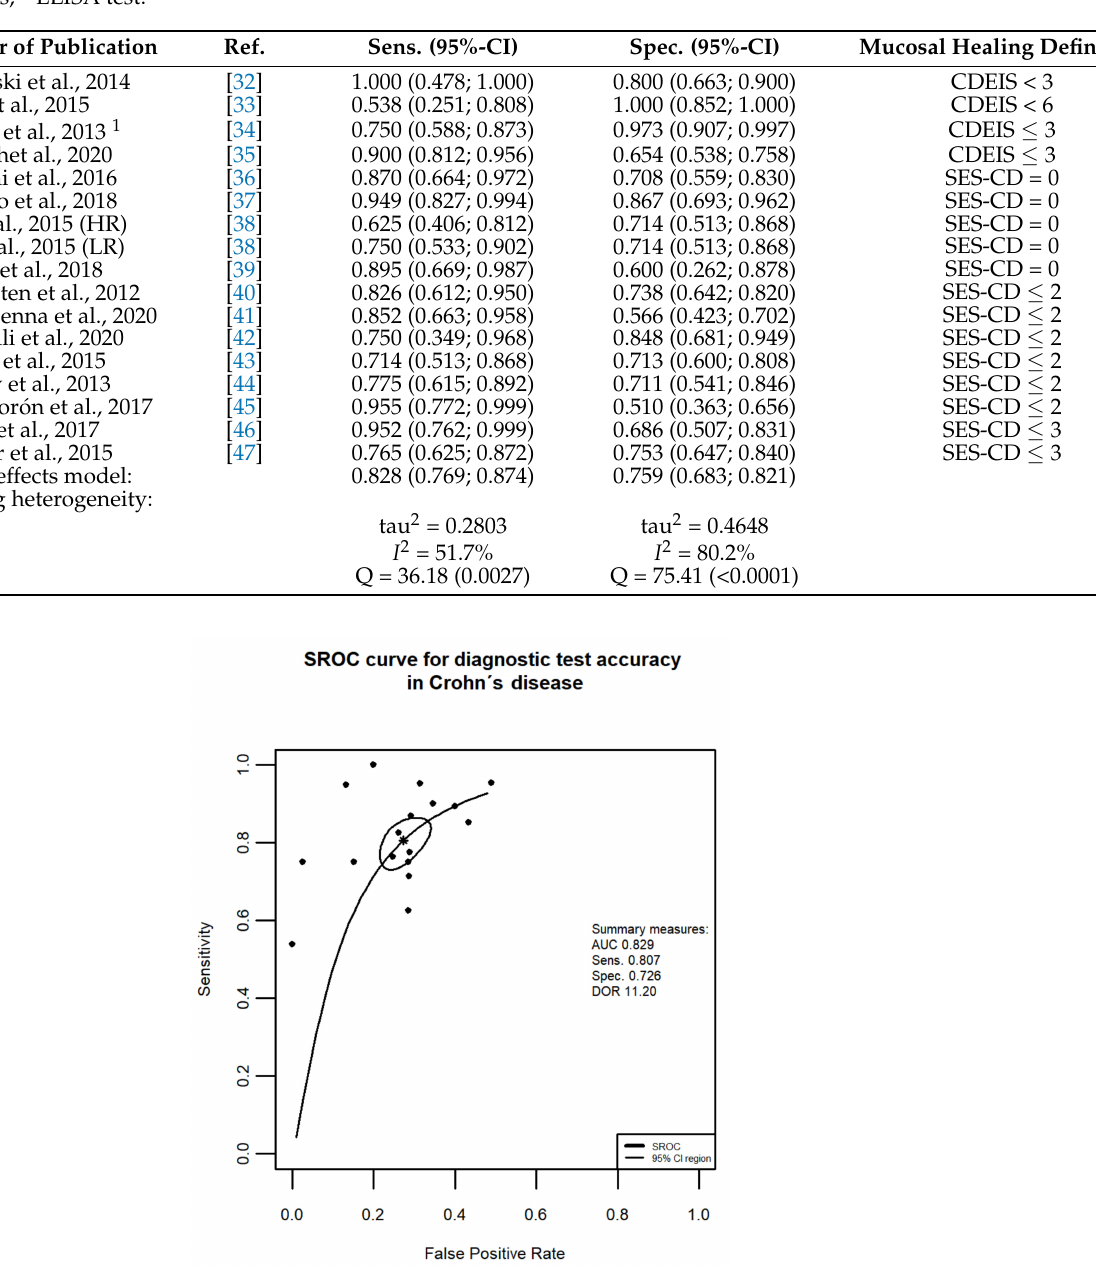
Table 1. Diagnostic test sensitivity and specificity calculated for the use of FC as the biomarker of mucosal healing in Crohn’s disease. Studies are grouped by the MH definition applied. Abbreviations: CDEIS, Crohn’s Disease Endoscopic Index of Severity; CI, confidence interval; MH, mucosal healing; SES-CD, Simple Endoscopic Score for Crohn’s Disease; Sens., sensitivity; Spec., specificity. Notes: Jusu é et al. compared High Range (HR) and Low Range (LR) Quantum Blue rapid kits; 1 ELISA test.